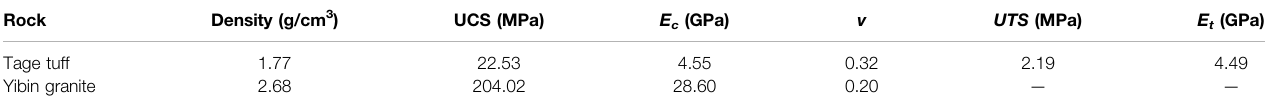
TABLE 1 | Physicomechanical properties of the specimens.